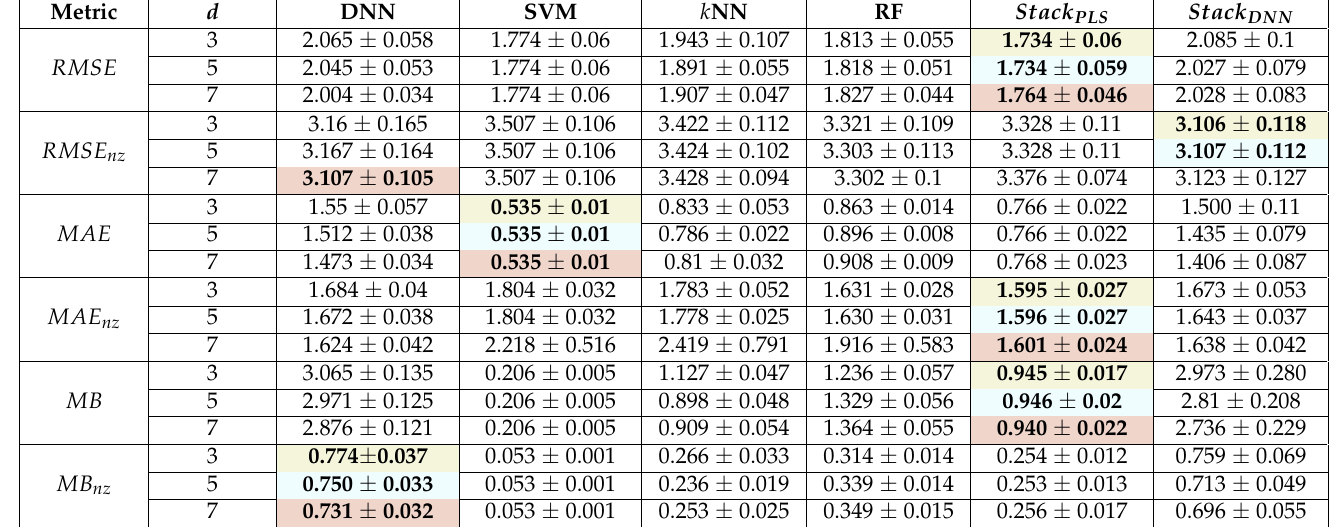
Table 1. Experimental results obtained. 95% CIs are used for the